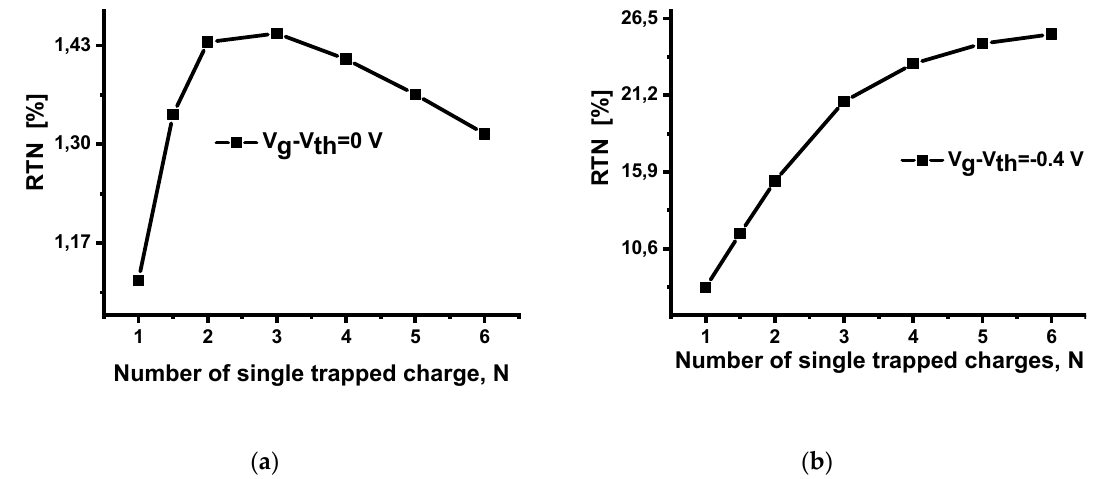
Figure 9. RTN amplitude dependence on the number of the single charge trapped in the defect area at gate overload 0 V ( a ) and − 0.4 V ( b ).